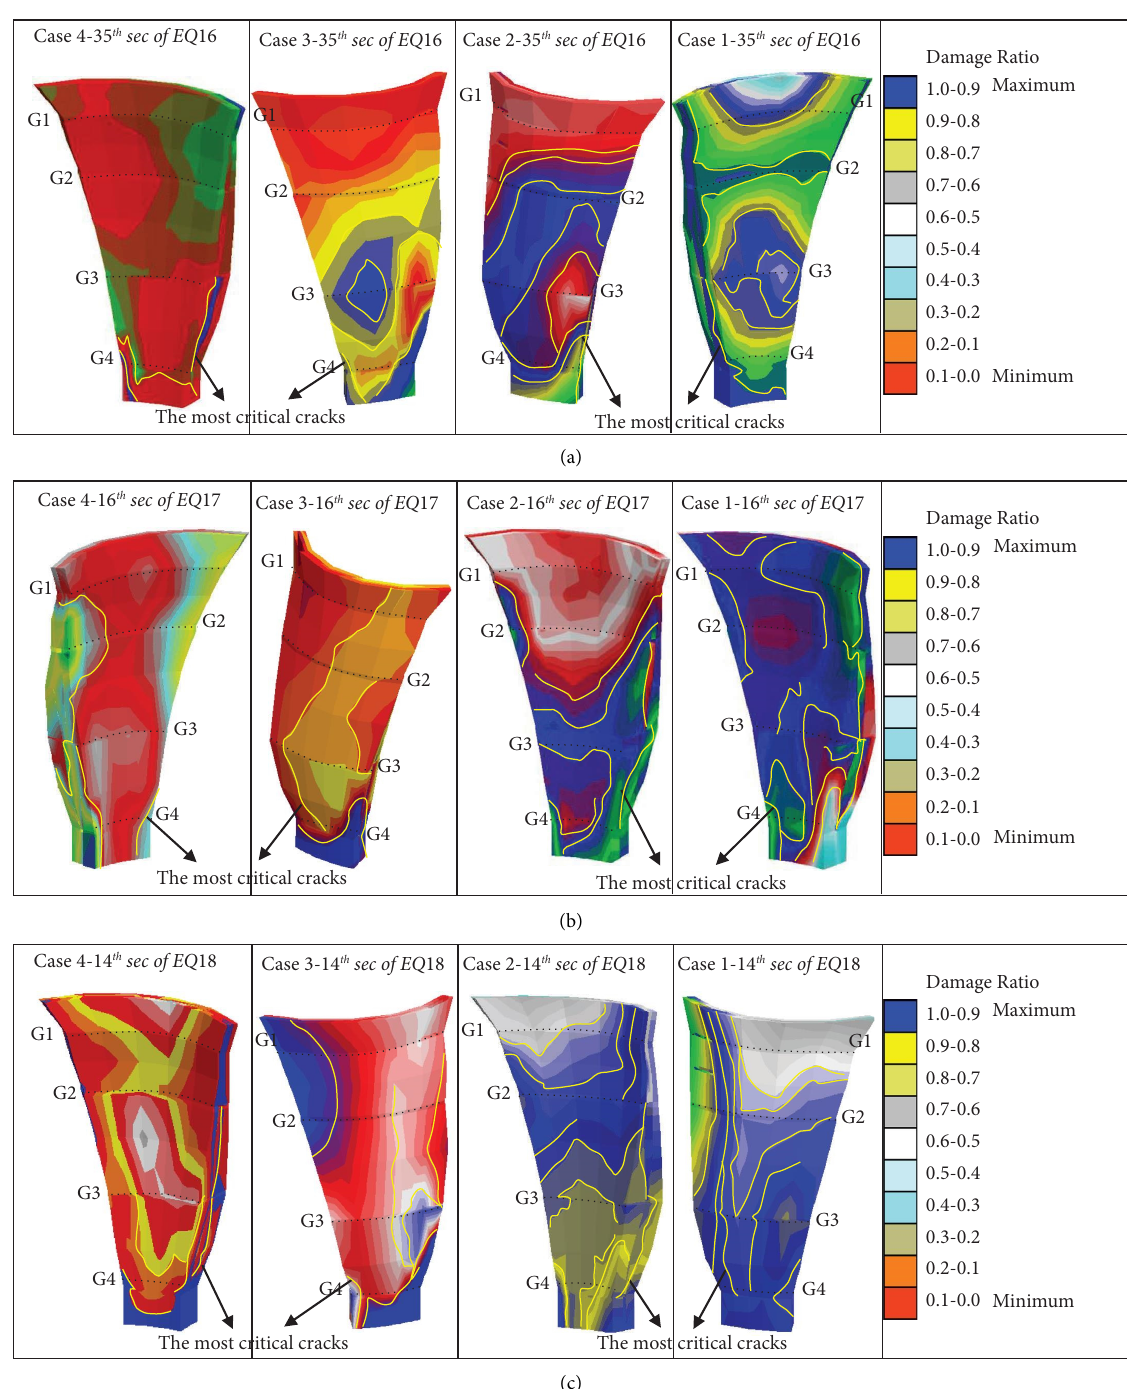
Figure 17: Earthquake crack performance of Ermenek arch dam for (a) EQ16 earthquake, (b) EQ17 earthquake, and (c) EQ18